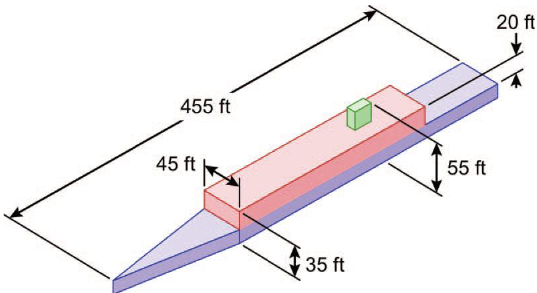
Figure 6. Mesh of SFS2 model. Figure 5. Schematic of SFS2 geometry. Figure 5. Schematic of SFS2 geometry. Figure 5. Schematic of SFS2 geometry.